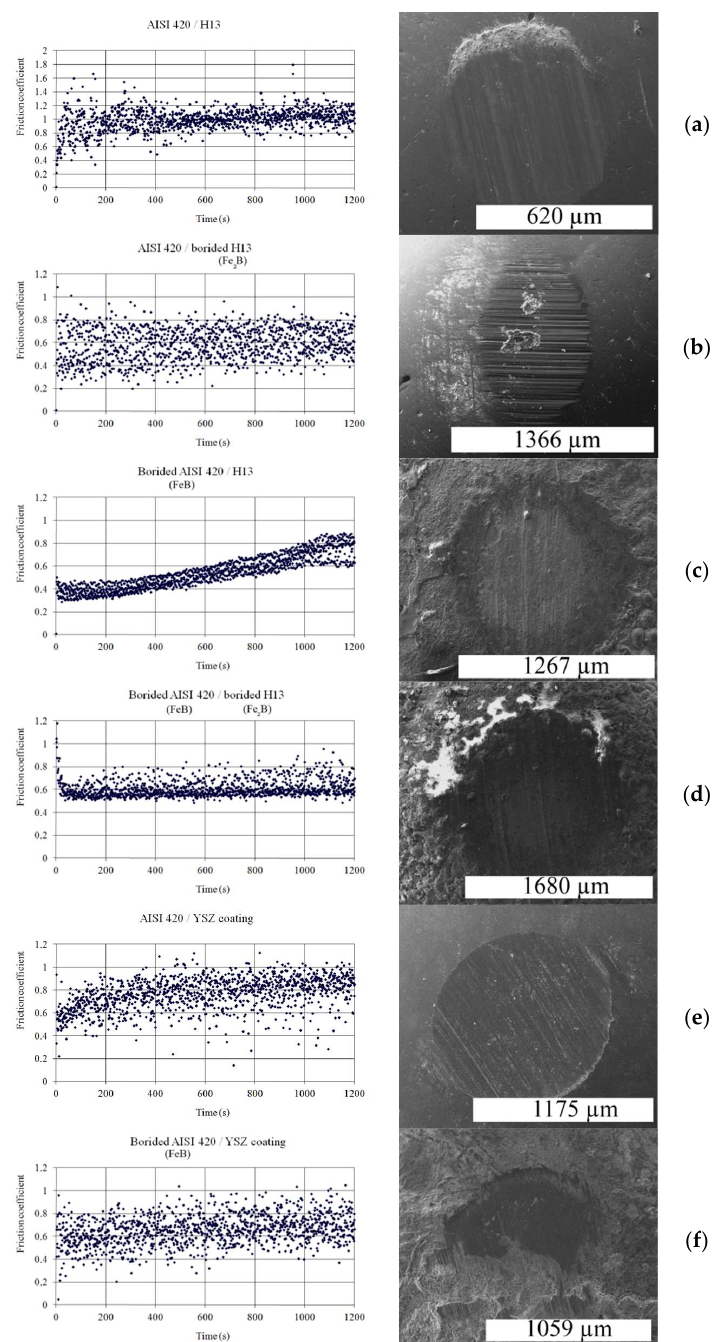
Figure 4. Friction coefficient as a function of time and post mortem ball (SEM, secondary electrons, front views): ( a ) Ball: AISI 420, disk: H13; ( b ) Ball: AISI 420, disk: Fe 2 B layer; ( c ) Ball: FeB layer, disk: H13; ( d ) Ball: FeB layer, disk: Fe 2 B layer; ( e ) Ball: AISI 420, disk: yttria-stabilized zirconia (YSZ) coating; ( f ) Ball: FeB layer, disk: YSZ coating. The scales on the right are adjusted to the average diameter of the